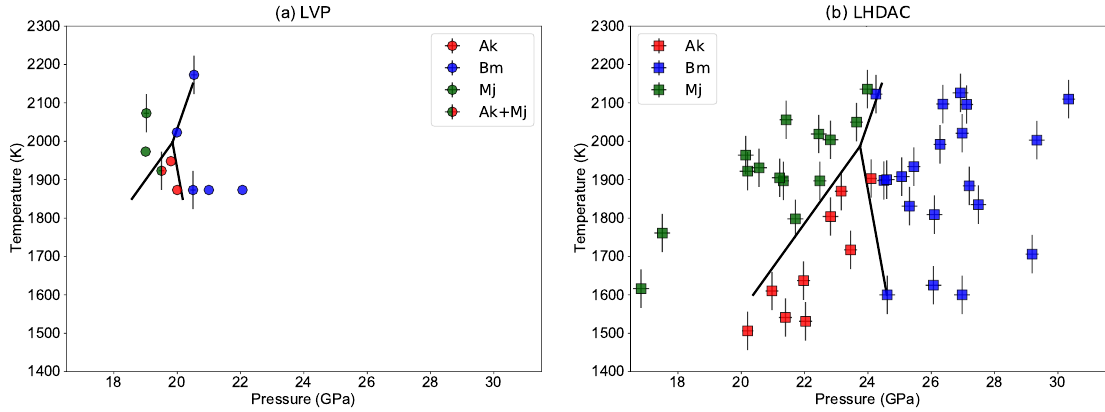
Figure 2. Data points from our ( a ) LVP and ( b ) LHDAC experiments: The red, green, and blue symbols represent Ak, Mj, and Bm, respectively. The estimated phase boundaries and triple point are shown. We fixed the Clapeyron slopes of the involved phase boundaries to those reported in Ishii et al. [37] and then adjusted the location of the phase boundaries to fit our data points. Our LVP triple point is located at 2000 ± 50 K and 19.9 ± 0.4 GPa. Our LHDAC triple point is located at 1990 ± 100 K and 23.8 ± 0.6